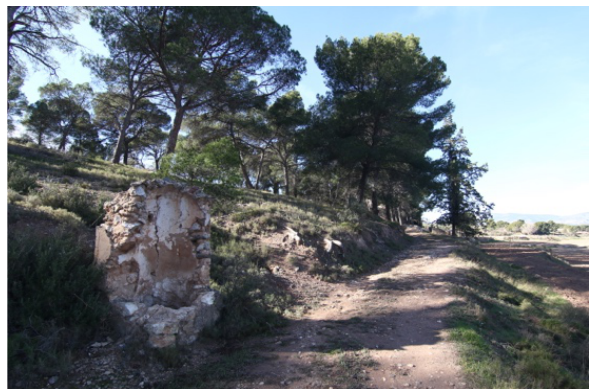
Figure 11. Cistern with a part of the top that protected the missing extraction system. The top, made of quarry stone with